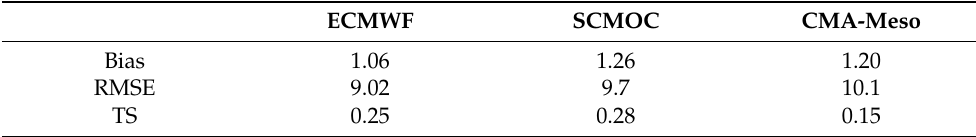
Table A1. The classical metrics of 74 rainstorm cases of three precipitation forecast